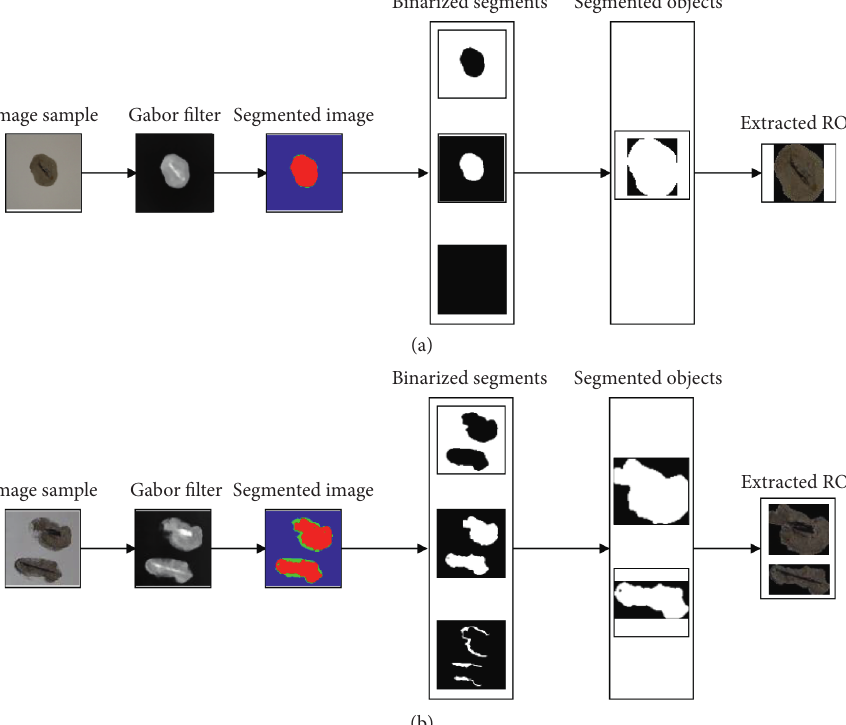
Figure 6: ROI extraction for images containing localized spall objects: (a) one object and (b) multiple